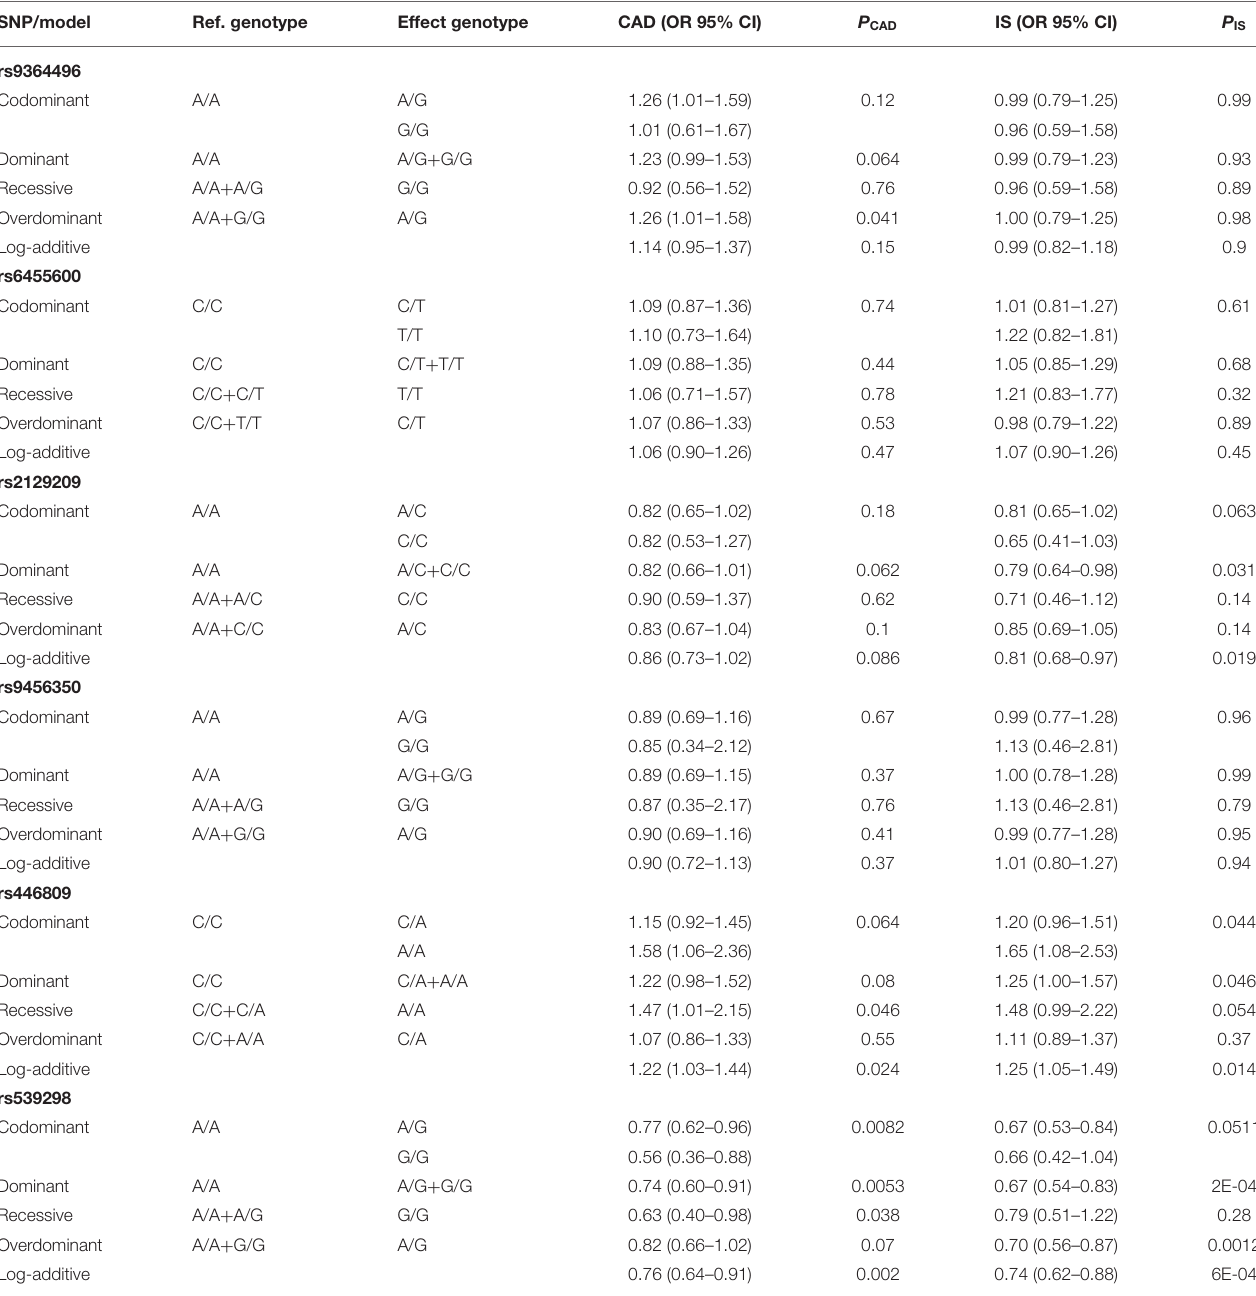
TABLE 3 | Genotypes of the six SYTL3 - SLC22A3 SNPs and the risk of CAD and